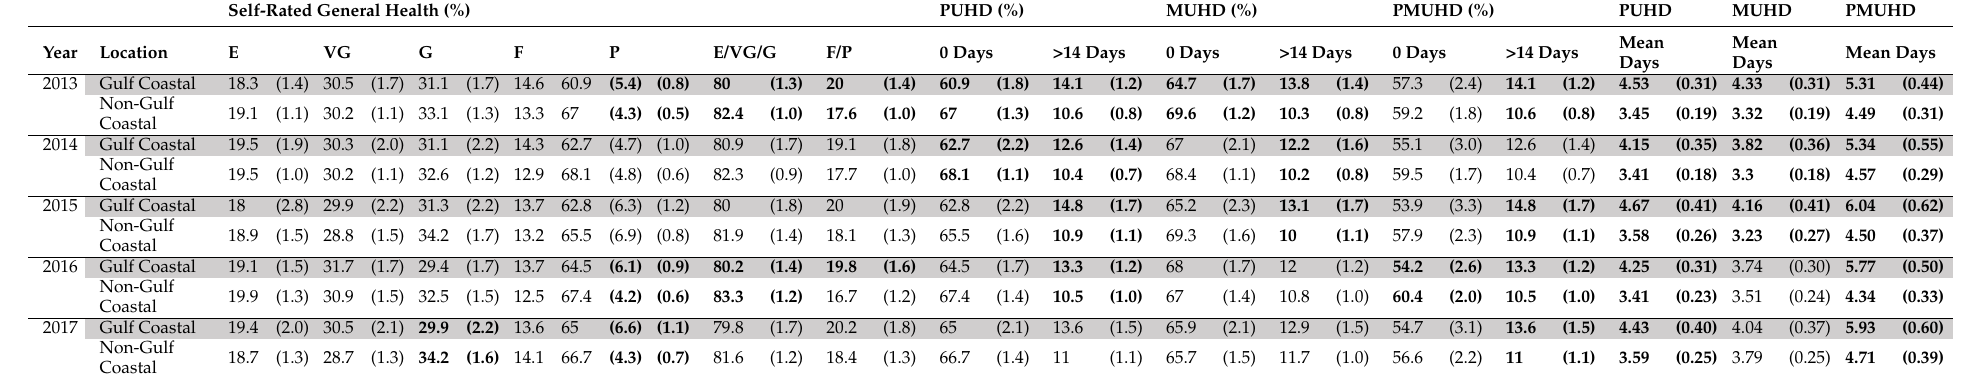
Table 4. Comparison of all Gulf Coastal vs. Gulf Non-Coastal MMSAs: Mean self-rated general health and unhealthy days. (See table notes for